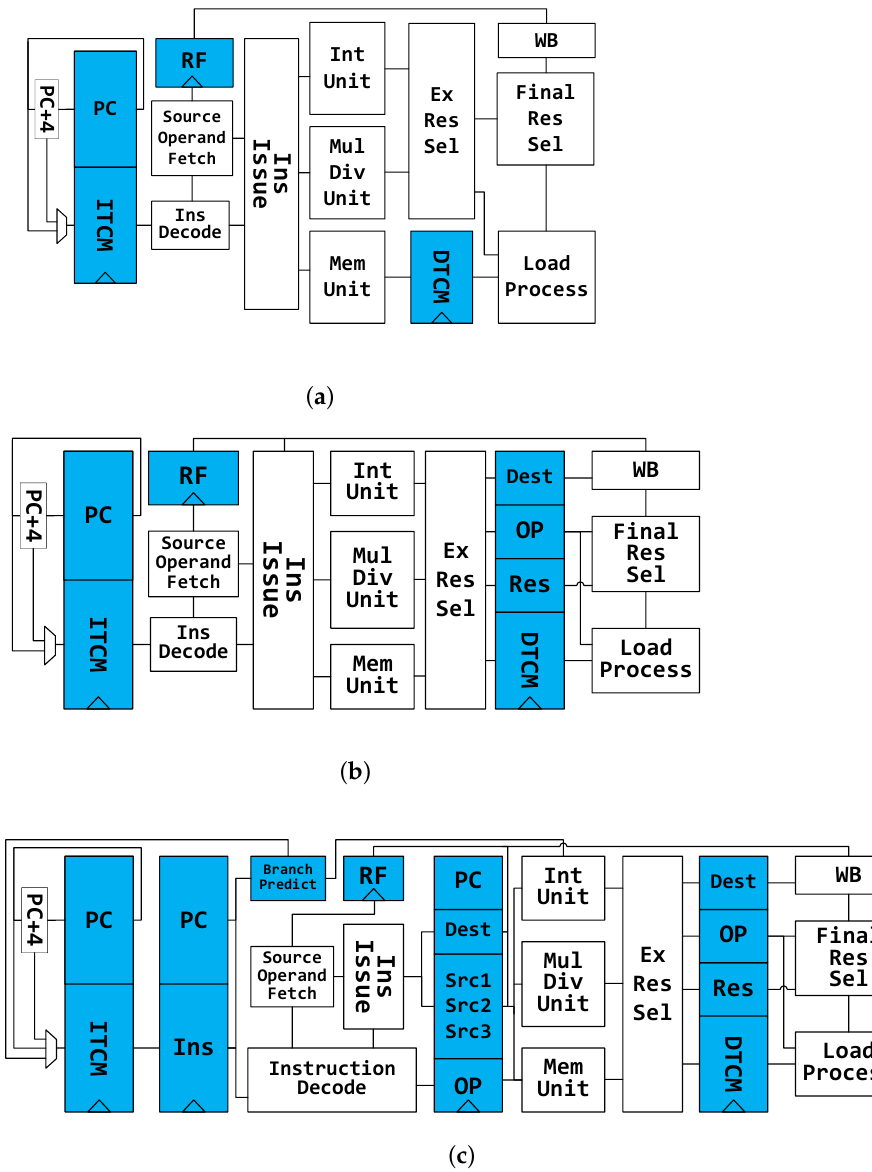
Figure 2. Architecture of baseline processors. ( a ) Architecture of TinyCore, ( b ) Architecture of LittleCore, ( c ) Architecture of